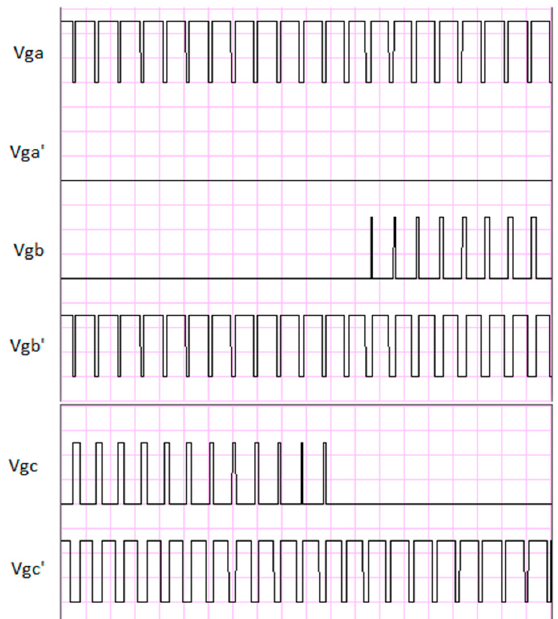
Figure 28. Space Vector Pulse Width Modulation (SVPWM) control signal generation in protease.